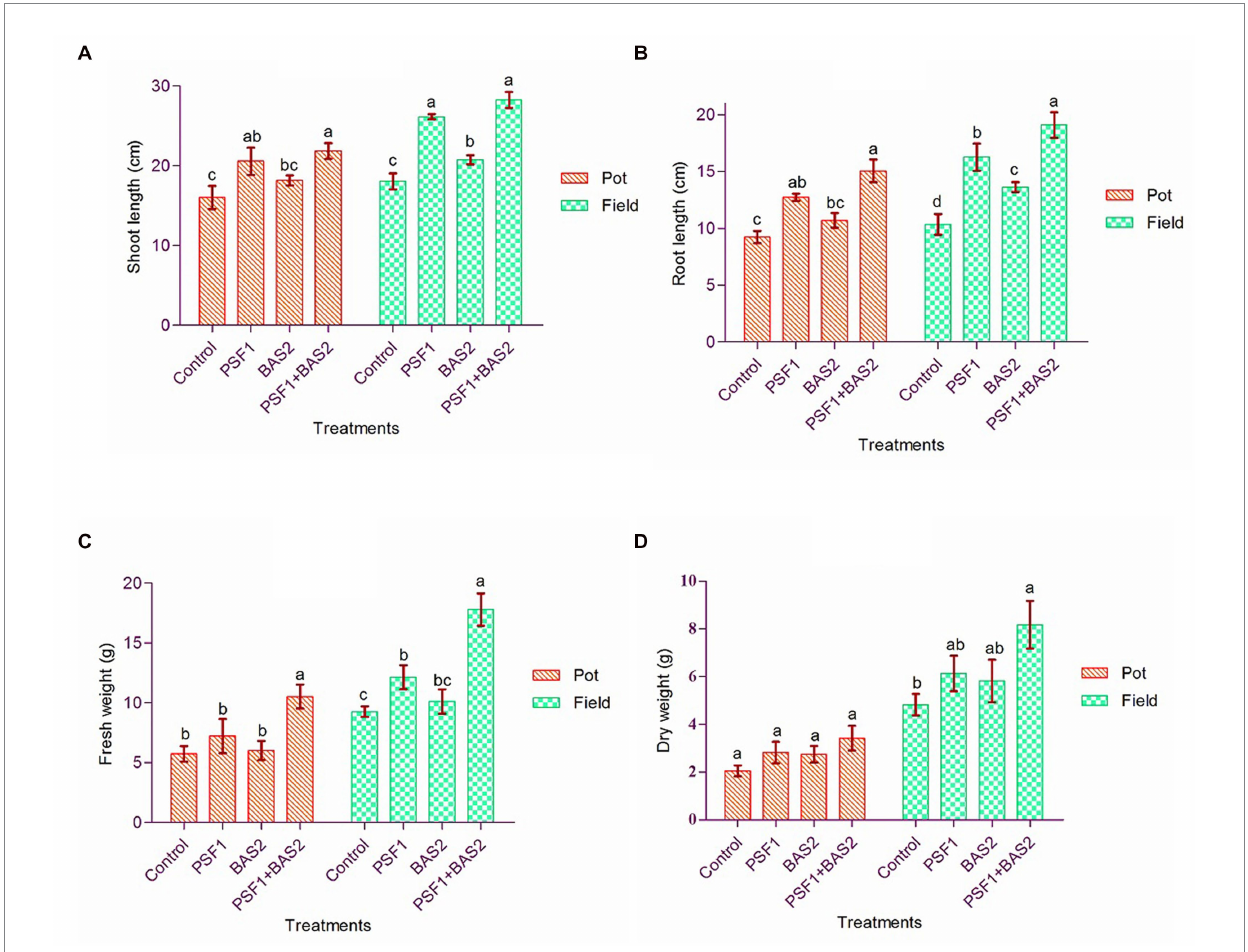
FIGURE 3 Effect of PGPR biostimulants Pseudomonas fluorescens (PSF1) and Bacillus subtilis (BAS2) on plant growth parameters in pot and field trial. Measured parameters (A) Shoot length; (B) root length; (C) plant fresh; and (D) dry weight. Error bar represents the standard deviation ( n = 3). Small